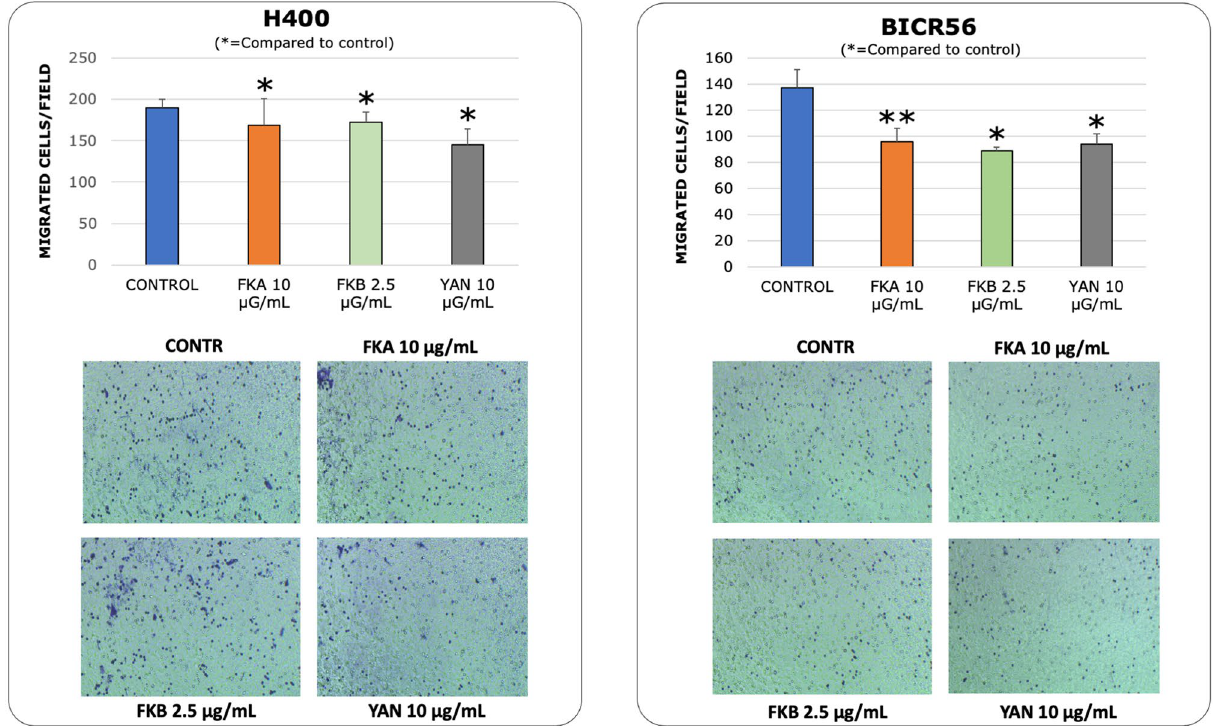
Figure 4. Migration assays. migrated cell count of H400 and BICR56 cells incubated with 10 μg/ml FKA, 2.5 μg/ml FKB and 10 μg/mL yangonin. The results were representative of 3 independent experiments. The 10 μg/mL yangonin. Data are represented as mean ± SD. Statistical significance is given as follows: * p < 0.05; ** p < 0.005; compared to control